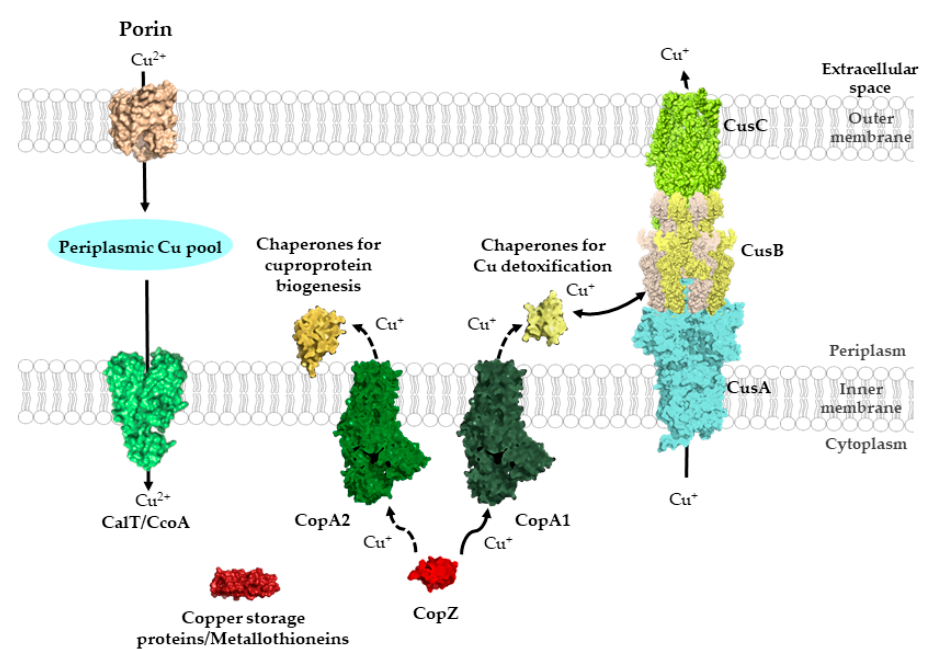
Figure 1. General view of Cu transport across bacterial membranes. Cu can cross the outer membrane of bacteria via porins and major-facilitator superfamily members, such as CcoA, can import periplasmic Cu into the cytosol. Additional Cu importers likely exist but have not been characterized in detail. Cytosolic Cu is bound by Cu storage proteins, metallothioneines and Cu chaperones, such as CopZ. Cu-chaperones also deliver Cu to P 1B -type ATPases for export into the periplasm. Kinetic di ff erences distinguish CopA1-like ATPases, which are involved in Cu detoxification, and CopA2-like ATPases, which export Cu for cuproenzyme biogenesis. CopA1-like ATPases are the primary interaction partner of CopZ, while the interaction with CopA2-like ATPases is particularly important at low Cu concentrations (dashed arrow). In the periplasm, di ff erent types of chaperones transfer Cu either for cuproenzyme biogenesis or for Cu export systems, as with the CusABC system. The structures shown were retrieved from the protein database (PDB) with the following IDs: 2ZFG (OmpF for Porin), 3WDO (YajR for CalT / CcoA), 5NQO (Csp3 for copper storage proteins), 1K0V (CopZ), 3j09 (CopA1, CopA2) 4WBR (ScoI / SenC, chaperones for cuproprotein biogenesis), 2VB2 (CusF, chaperones for Cu detoxification), 3KSS (CusA), 3H94 (CusB), 4K7R (CusC), and are depicted using Pymol